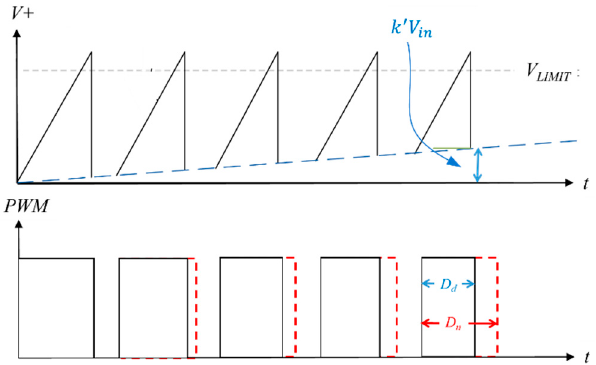
Figure 5. Waveforms of a primary-side controlled flyback with FFC control working in DCM.